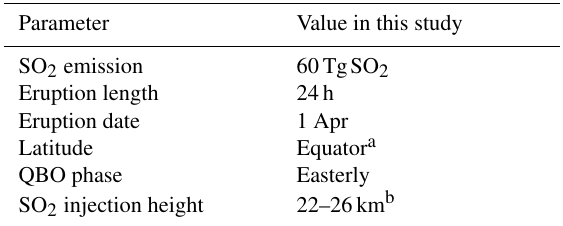
Table 2. Model parameters used for the Tambora